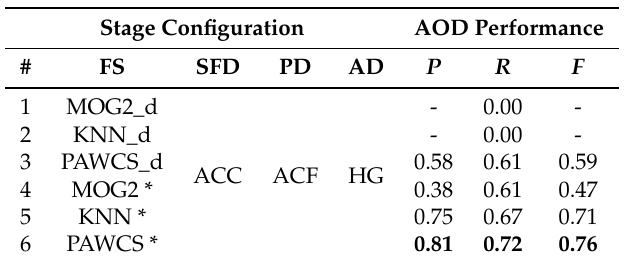
Table 6. Results comparing foreground segmentation approaches for AOD performance. Bold indicates the best results. Key: FS = Foreground Segmentation. SFD = Stationary Foreground Detection. PD = Pedestrian Detection. AD = Abandoned Discrimination. P = Precision. R = Recall. F = F-score. ACF = Aggregated Channel Feature. HG = High Gradients.